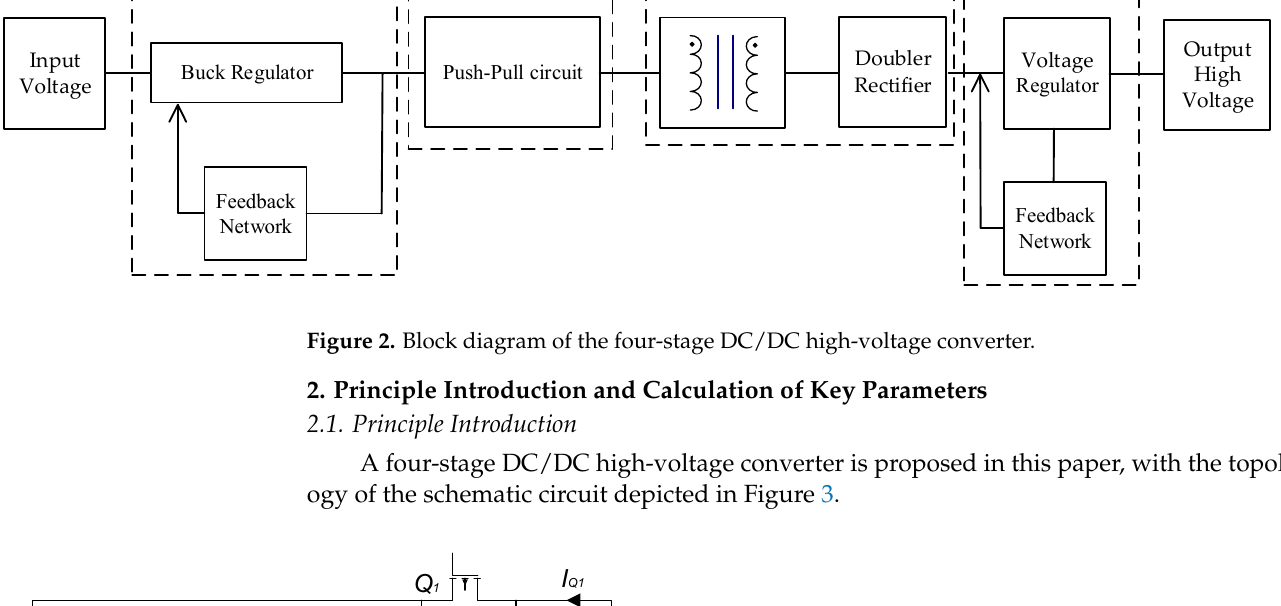
Figure 2. Block diagram of the four-stage DC/DC high-voltage converter.